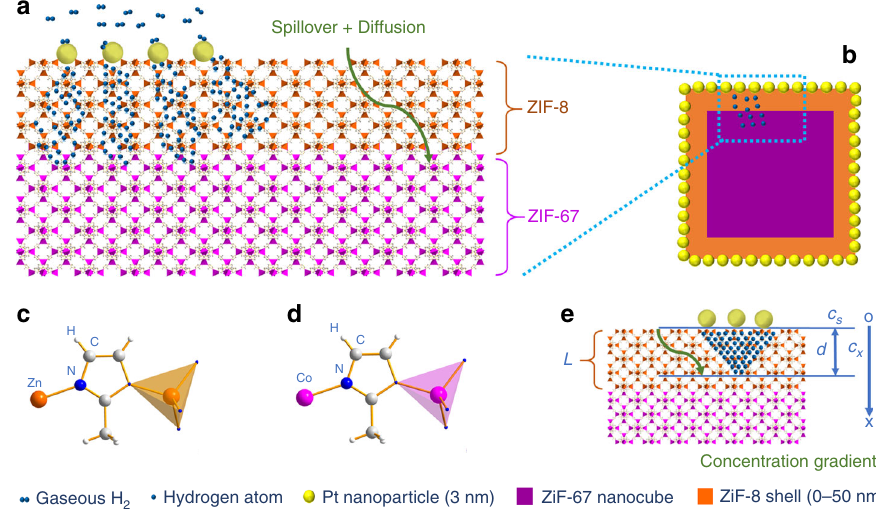
Fig. 1 Schematic representation for the hydrogen spillover over ZIF-8. a The proposed pathway of hydrogen spillover in ZIF-8, which includes dissociative chemisorption of H 2 on Pt surface, and subsequent migration of H atoms onto ZIF-8 via spillover and diffusion, fi nally, hydrogenolysis of ZIF-67 if H atoms arrive the ZIF-67 layer, b ZIF-67@ZIF-8/Pt model catalyst in a cross-section view, c , d the Zn – MeIm – Zn and Co – MeIm – Co linkages the periodic ZIF-8 and ZIF-67 crystals, where the coloured tetrahedrons represent primary building units in ZIFs, and e Schematic of concentration gradient of hydrogen atoms and the coordinate system of the model discussed in the main text, where L is the shell thickness of ZIF-8, and d is the penetration depth of hydrogen